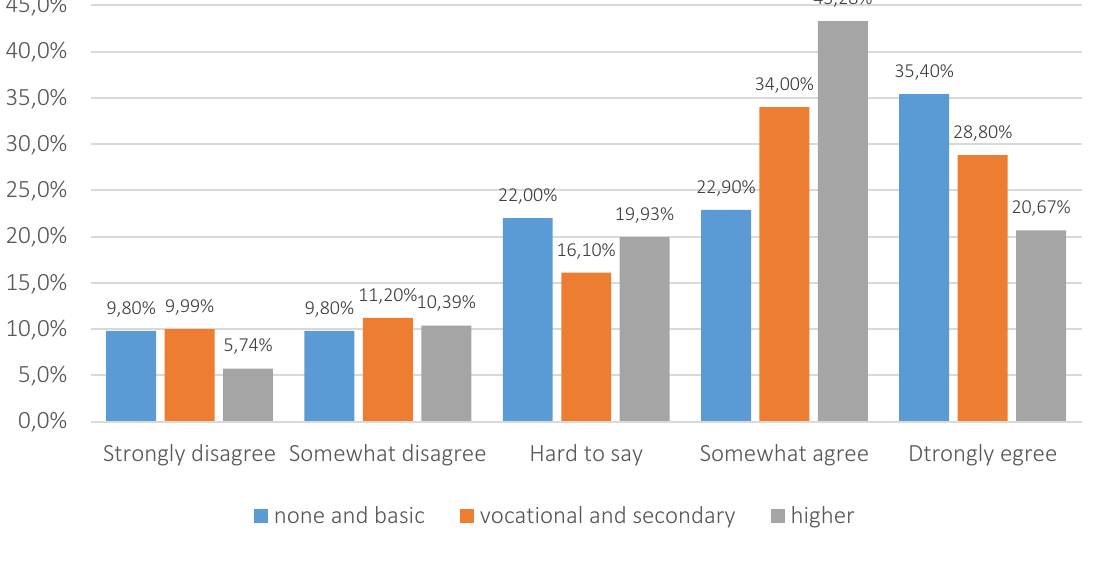
Figure 4. The quality of interpersonal relationships at work vs. a respondent’s education